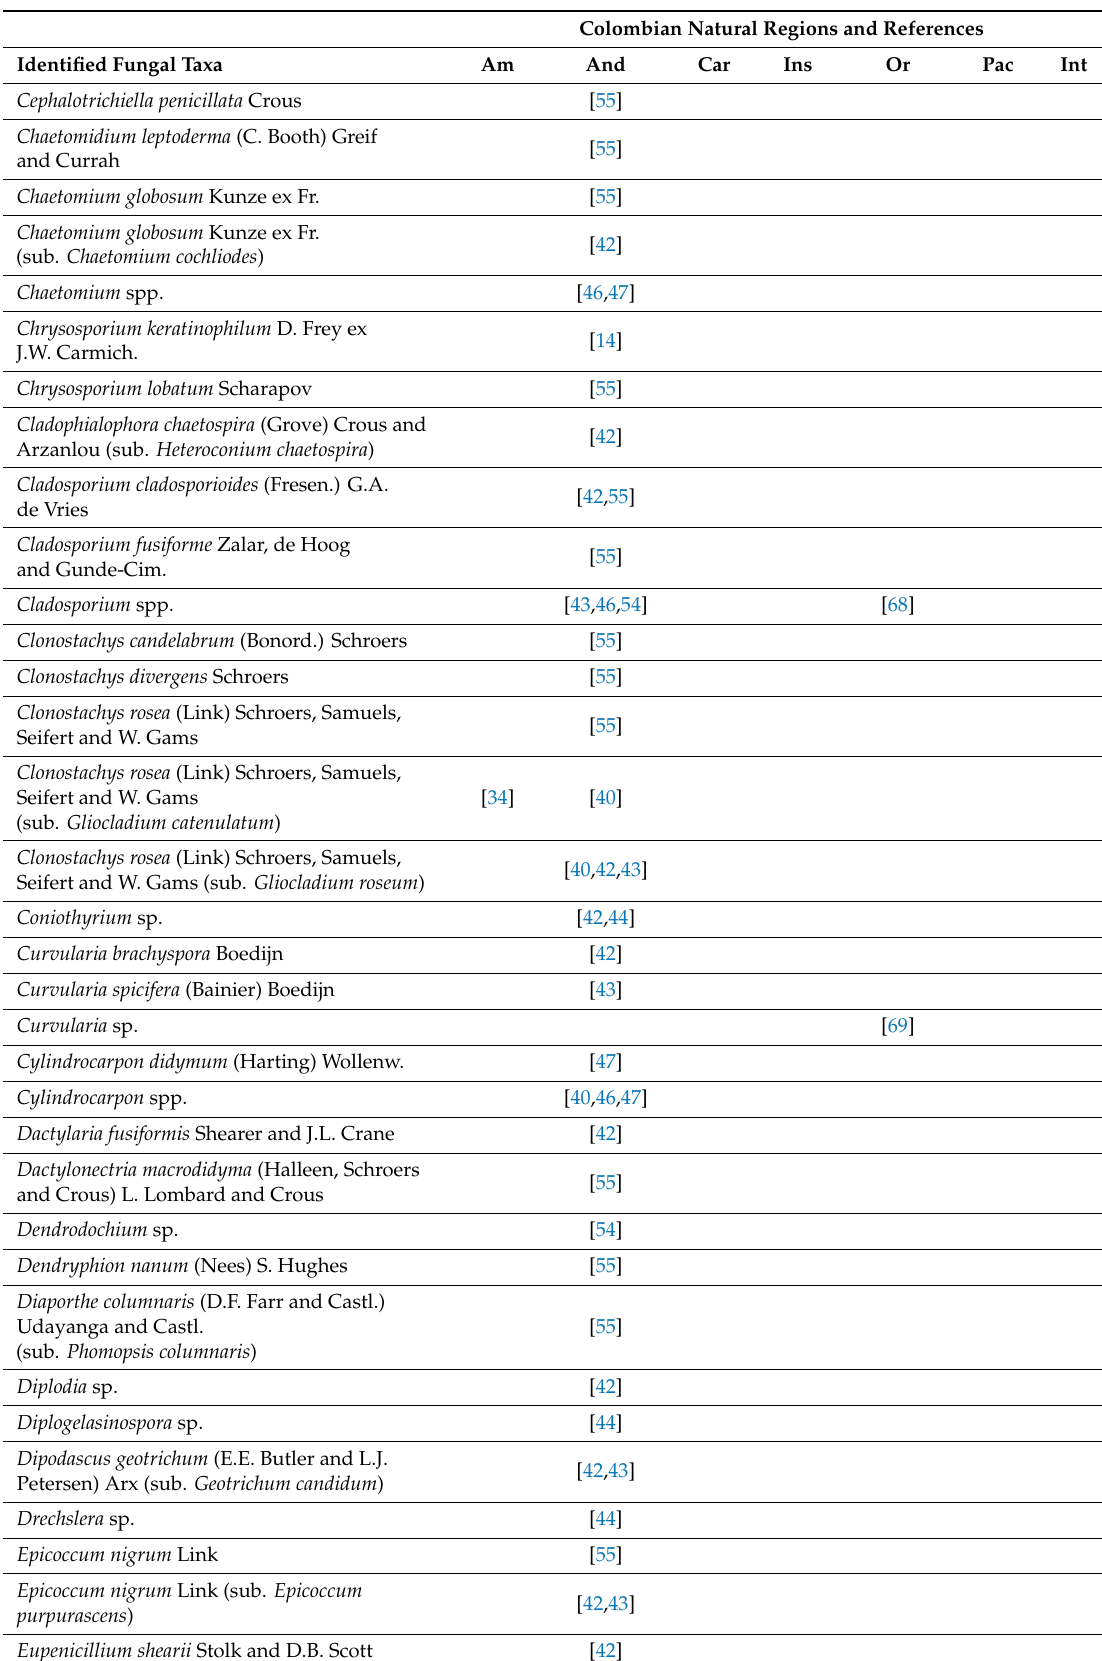
Table 1. Cont . Colombian Natural Regions and